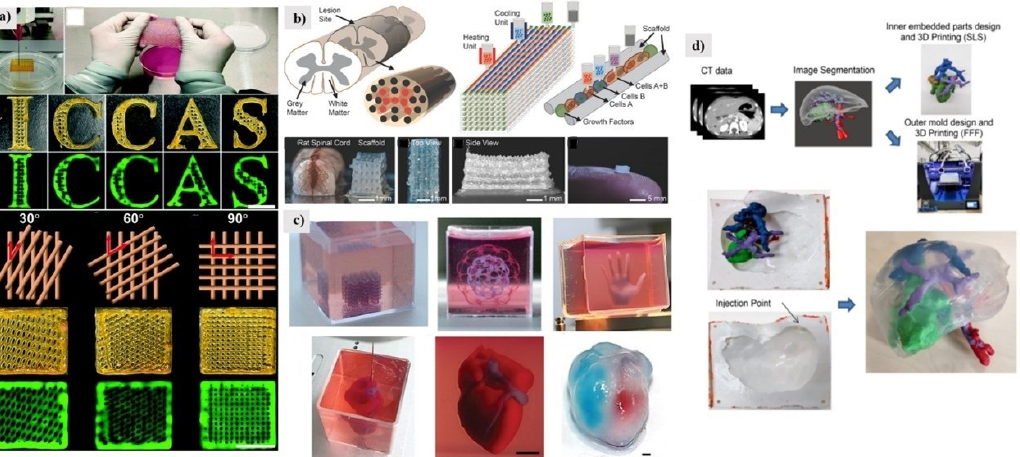
Figure 5. ( a ) 3D architectures printed from the Gel/Alg/HA/PPV ink. Reproduced with